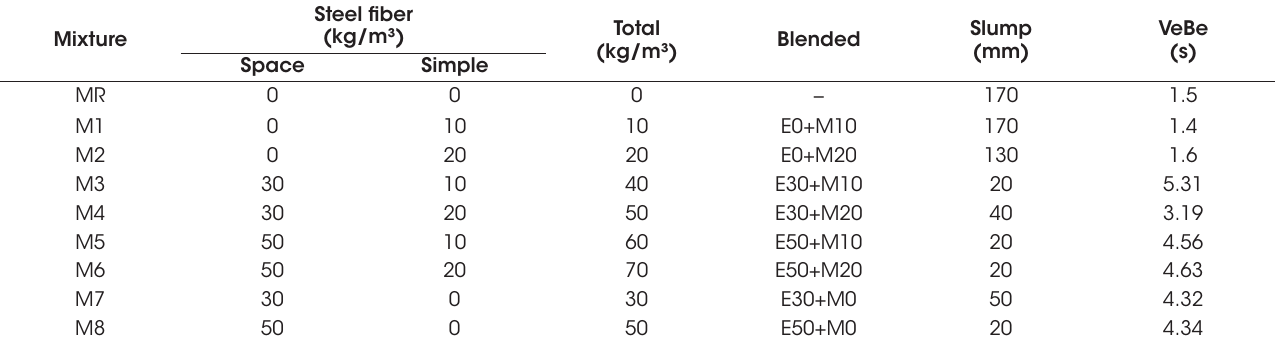
Fresh-state results of the mixtures Mixture